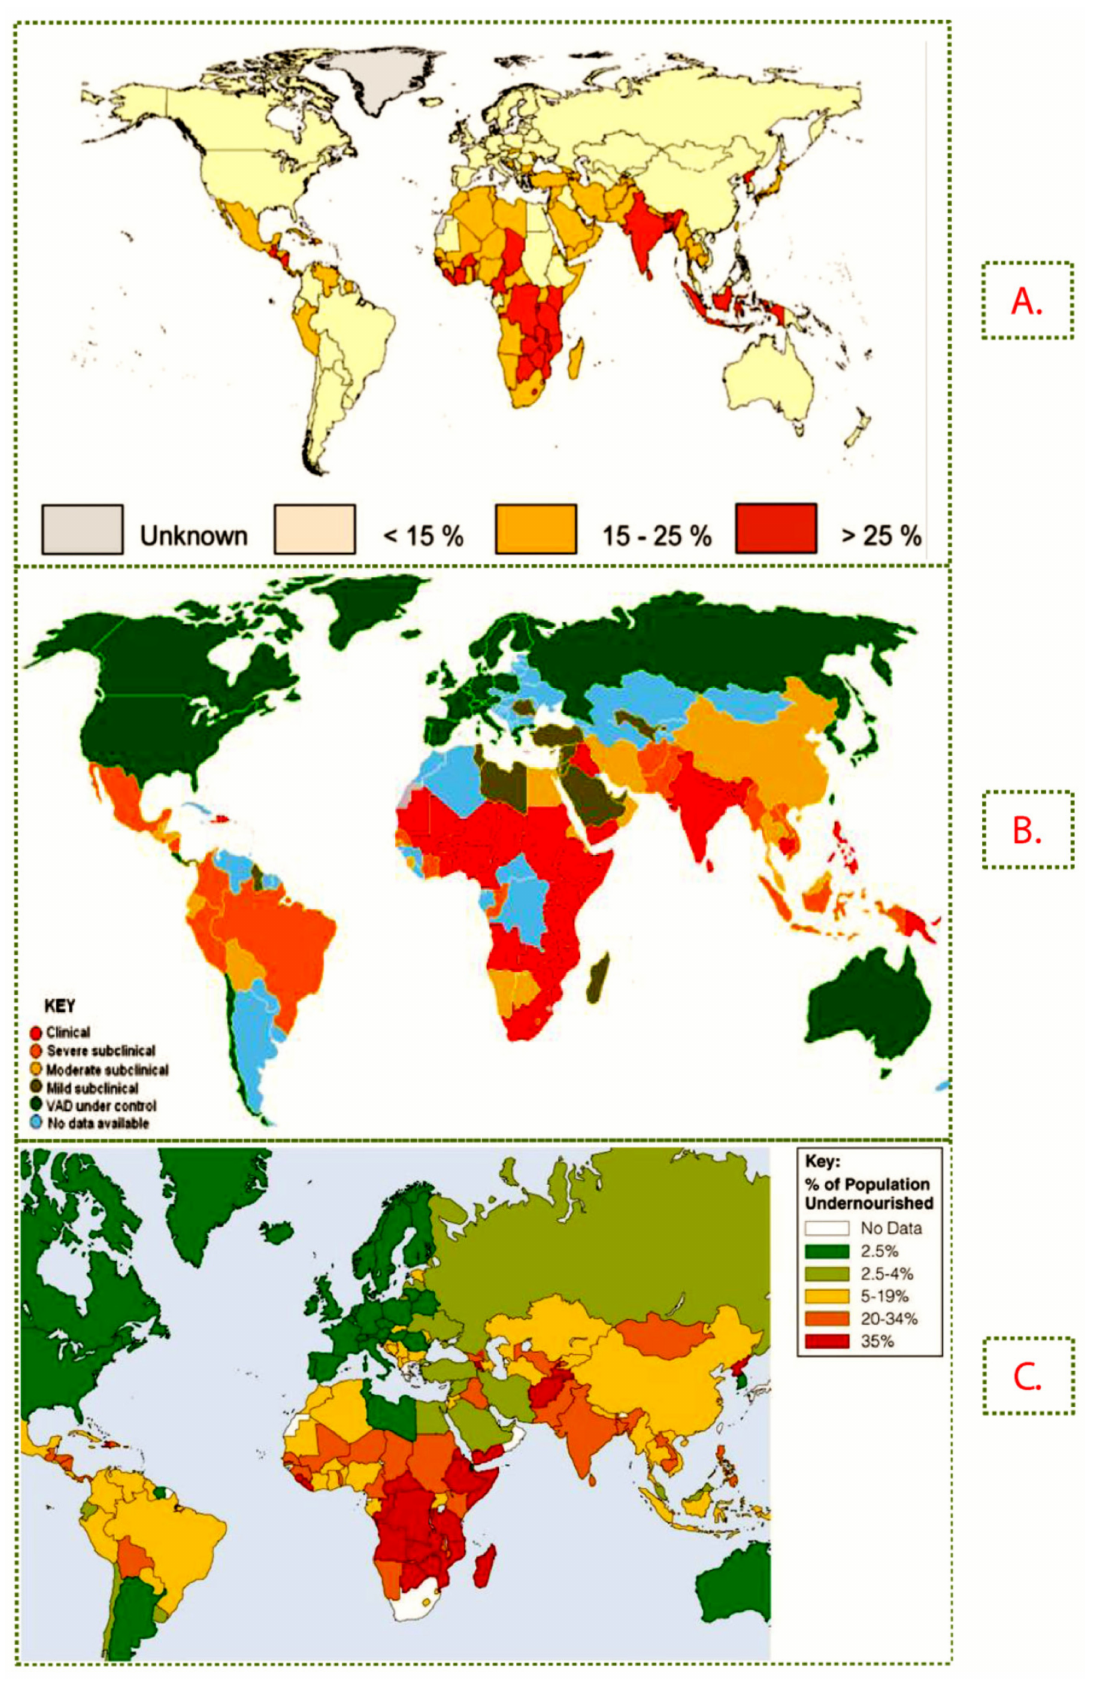
Figure 1. The estimated prevalence of ( A ) Zn deficiency ( B ) vitamin A deficiency ( C ) protein deficiency across the world